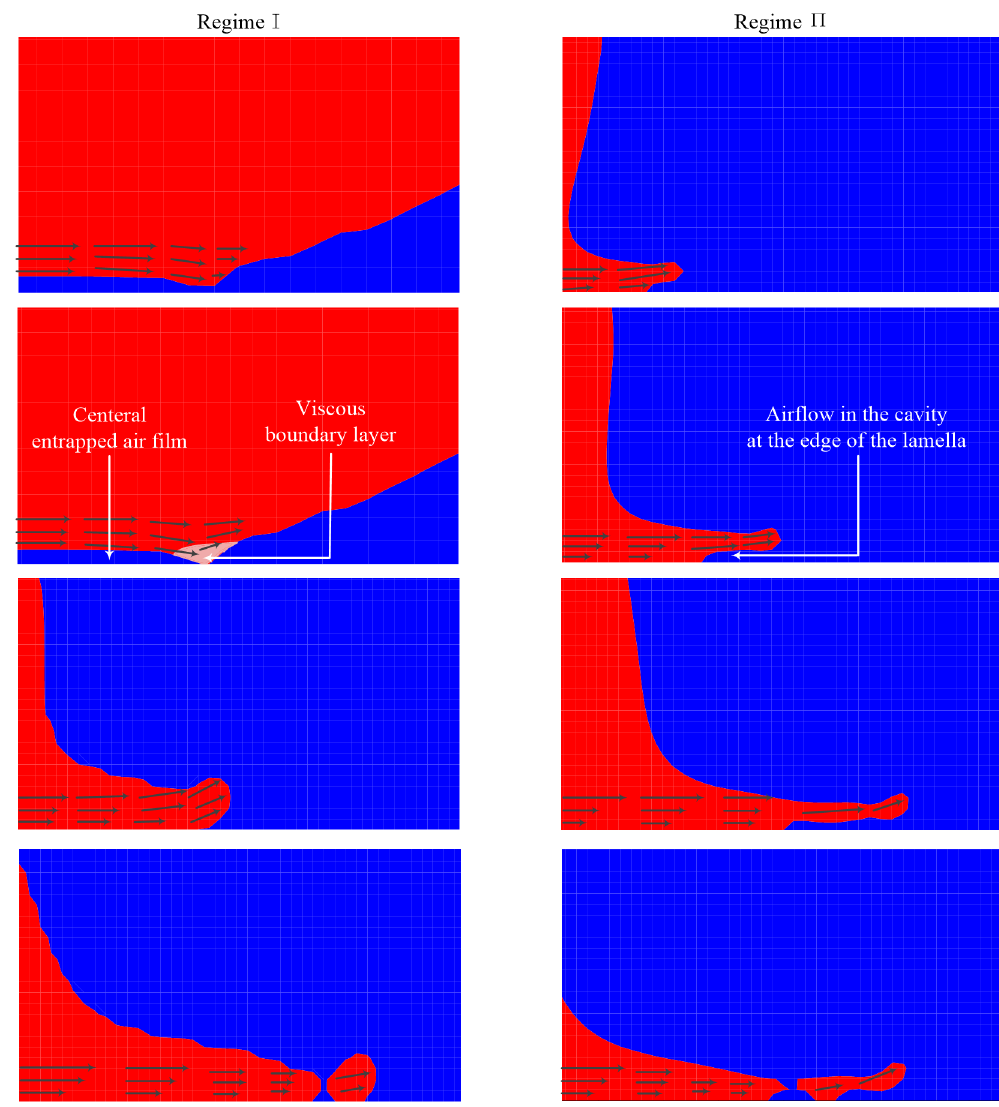
Fig 6. Splashing mechanism. A schematic summarizing the postulatedmechanisms for the initial drop splash in Regime Ⅰ (left) and Regime Ⅱ (right). Shown on the left is a sequenceof volume fraction contours starting from the instant the air film rupturesor otherwiseallows contact, while on the right is a sequencestarting from an instant the lamellashows significantupwarddeflectionsbut has not beenbroken up.